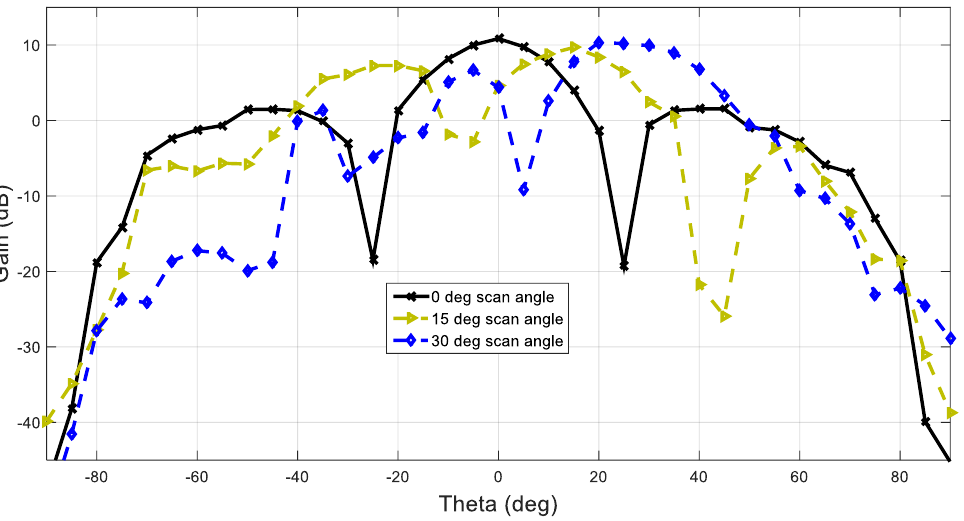
Figure 15. Measured pattern results of a 1 × 4 phased array with P-CRLH excited